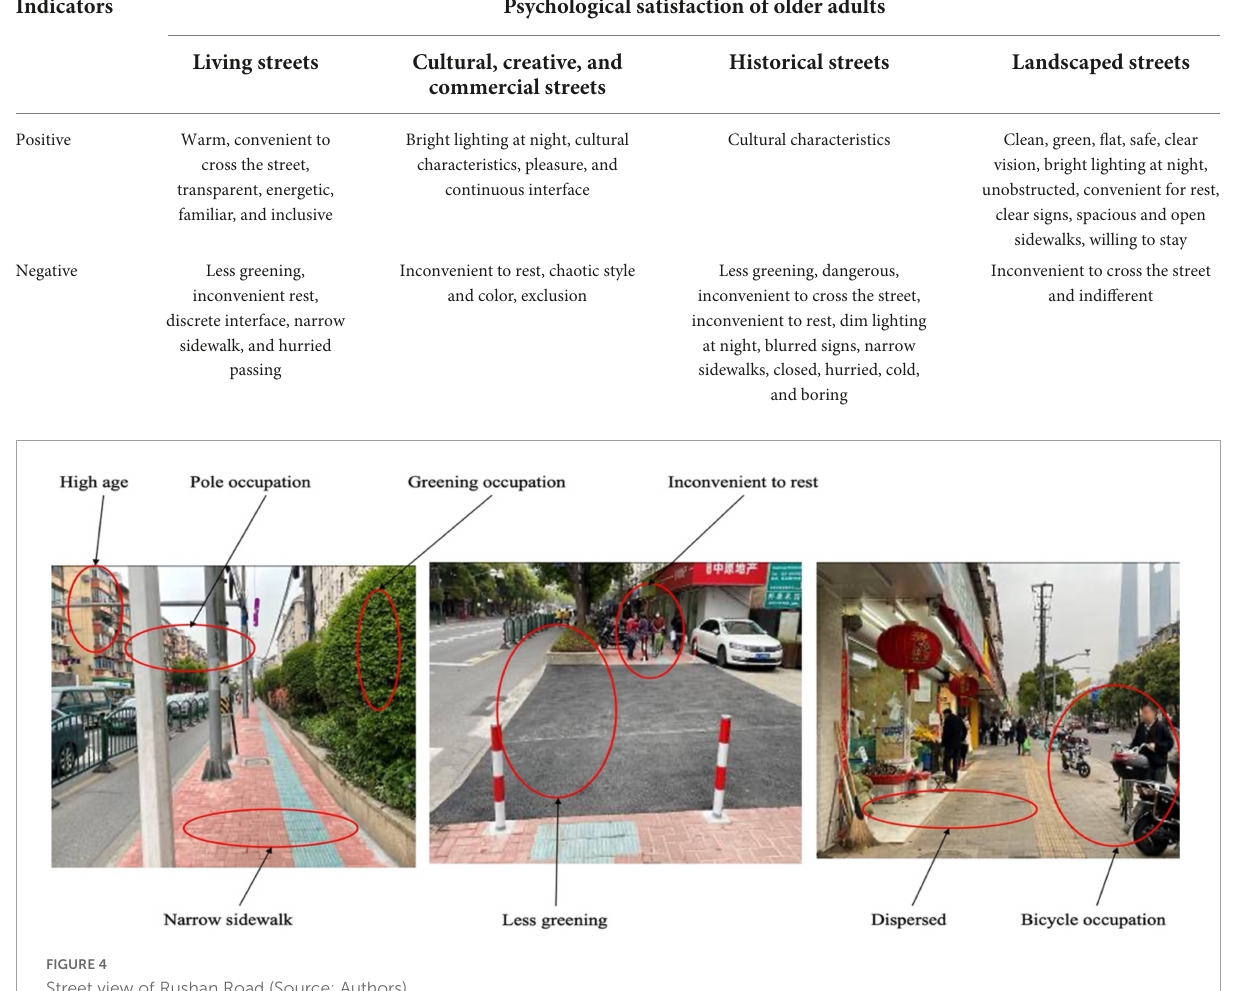
TABLE 5 Interview results for psychological satisfaction of older adults in four types of streets.